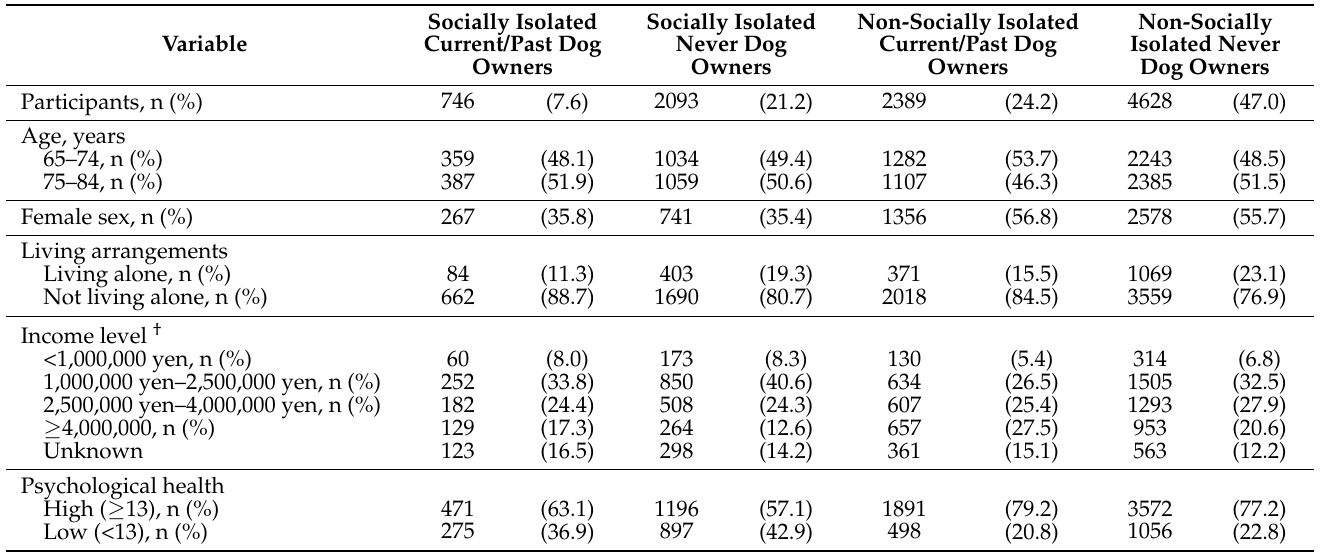
Table 1. Demographic characteristics of 9856 socially and non-socially isolated community-dwelling older adults with or without experience of dog